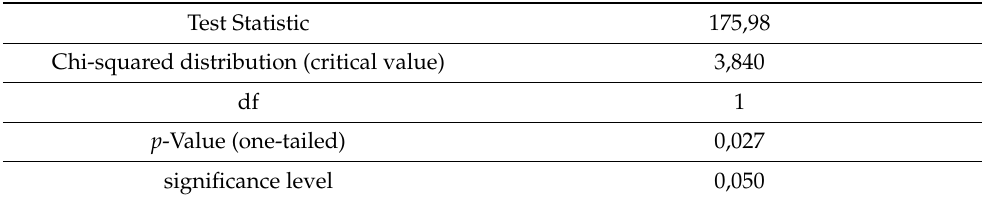
Table 2. Cochran’s test results: the “Test Statistic” refers to the Chi-squared distribution, the “critical value” is the threshold above which one should reject the null hypothesis, the “df” stands for the degrees of freedom, “ p -value” denotes the probability of wrongly choosing the true hypothesis, and “significance level” denotes the probability of rejecting the null hypothesis when it is true (Type I Error). Test Statistic 175,98 Chi-squared distribution (critical value) 3,840 df 1 0,027 significance